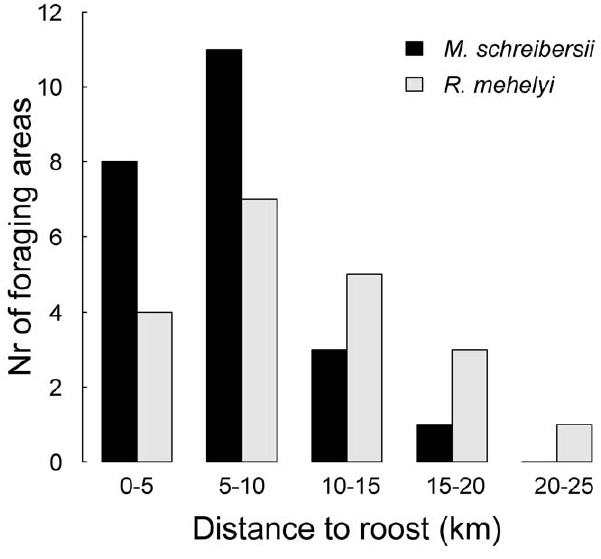
Figure 1. Linear distance between the roost and the centre of each foraging area located during this study. Most of these areas were used on multiple nights by the same bat.